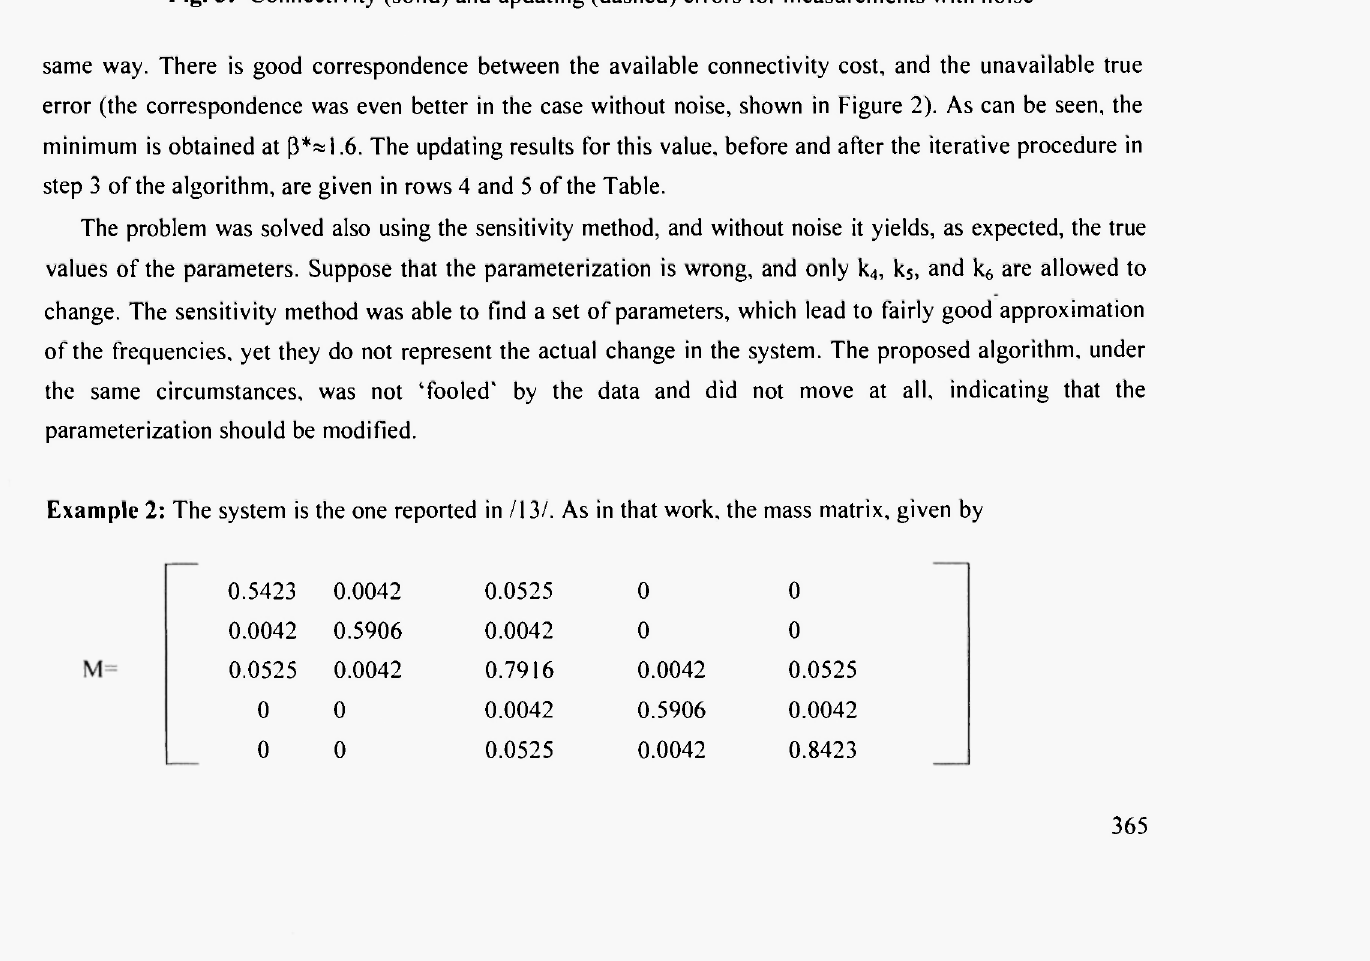
Fig. 3: Connectivity (solid) and updating (dashed) errors for measurements with noise